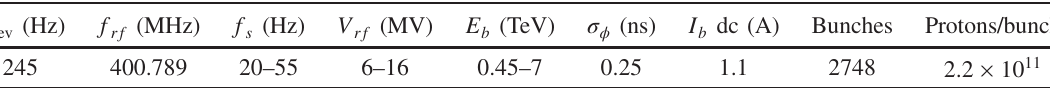
TABLE II. HL-LHC design rf parameters.